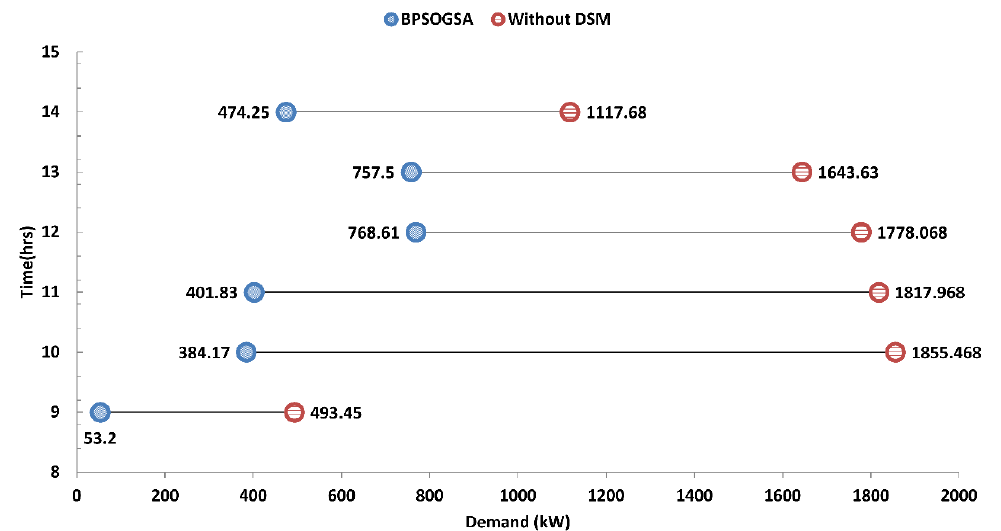
Figure 9. Variations in demand from 9:00 to 14:00 before and after deployment of BPSOGSA-DSM.